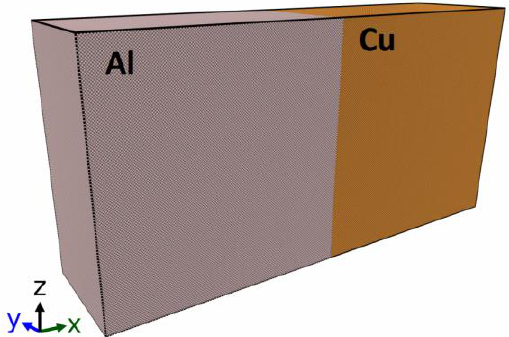
Figure 1. Initial state of a bimetallic system consisting of aluminum and copper parts.